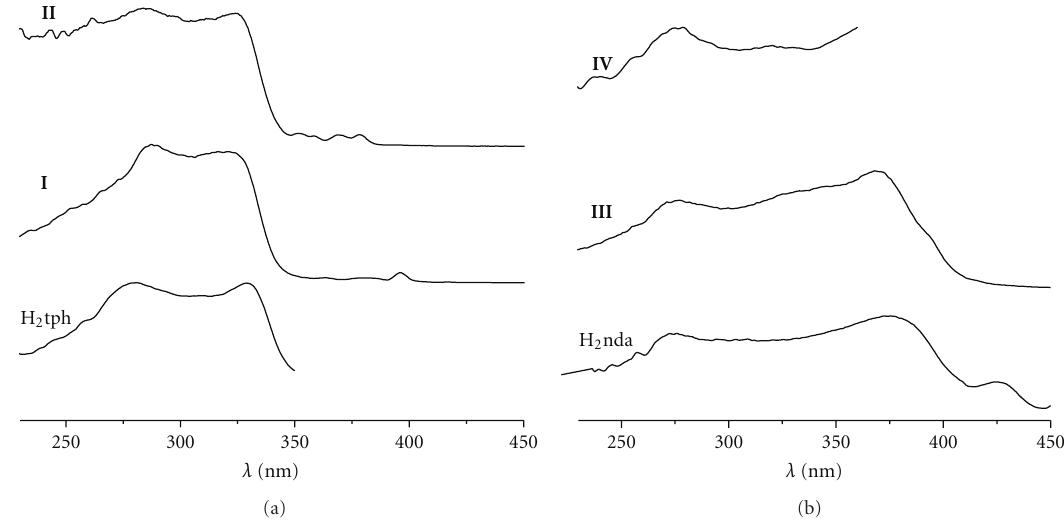
Figure 6: Normalized excitation spectra of H 2 tph ( λ em = 380 nm), Eu 2 (tph) 3 (H 2 O) 4 ( I , λ em = 612 nm), Tb 2 (tph) 3 (H 2 O) 4 ( II , λ em =